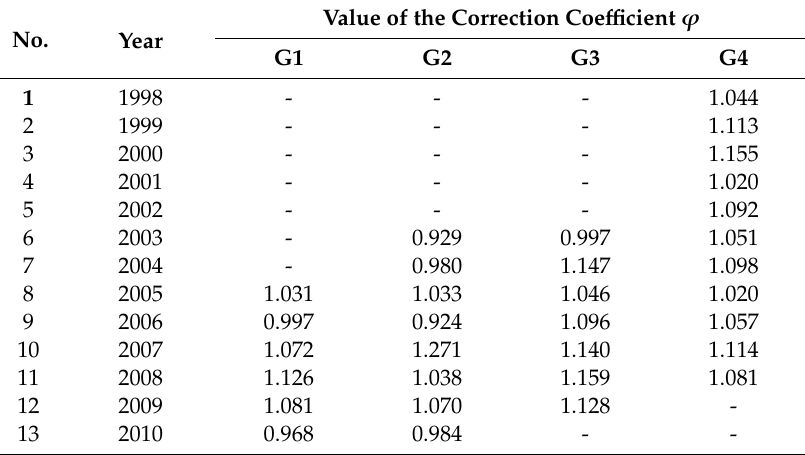
Table 2. Correction coe ffi cient ϕ